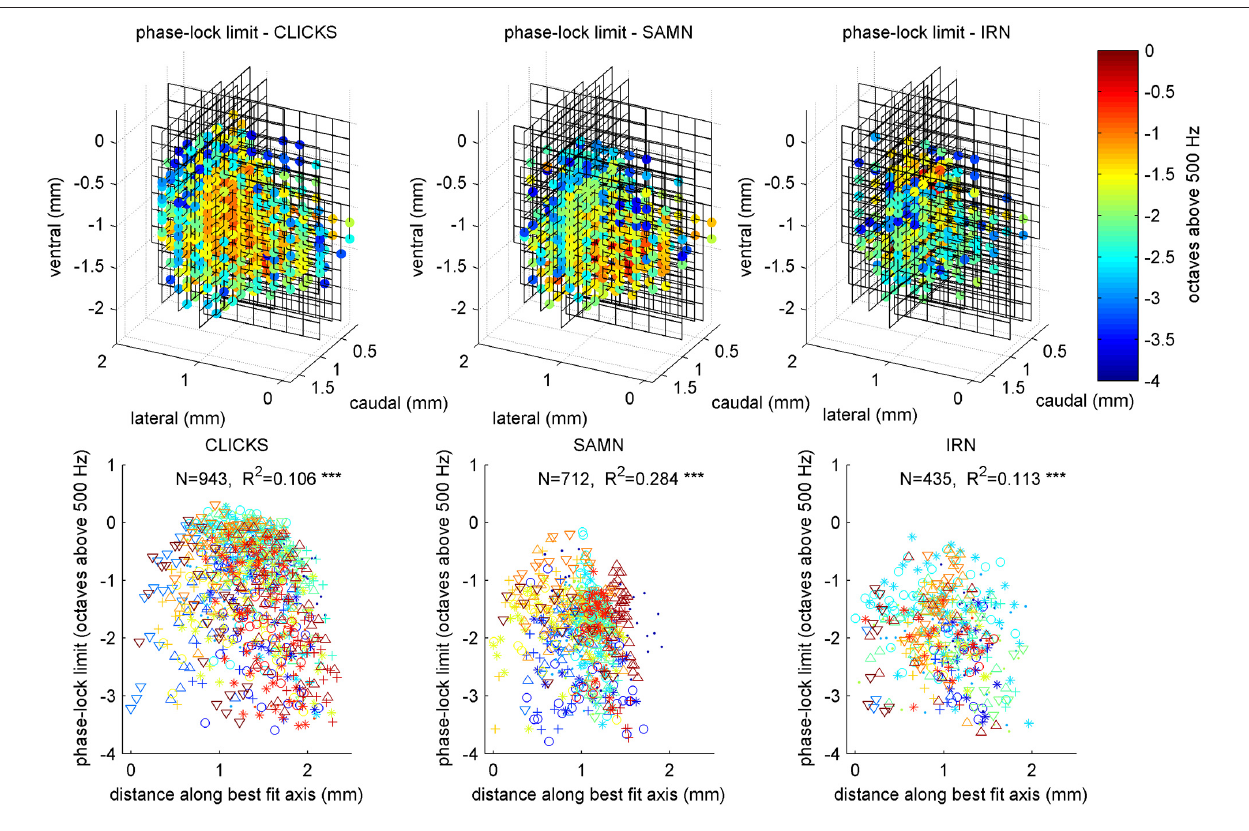
FIGURE 13 | Anatomical distribution of phase-lock limits (low-pass cutoff MFs) shown as 3D color maps (top row) and as scatter plots of cutoff MF against distance along a best fit anatomical axis